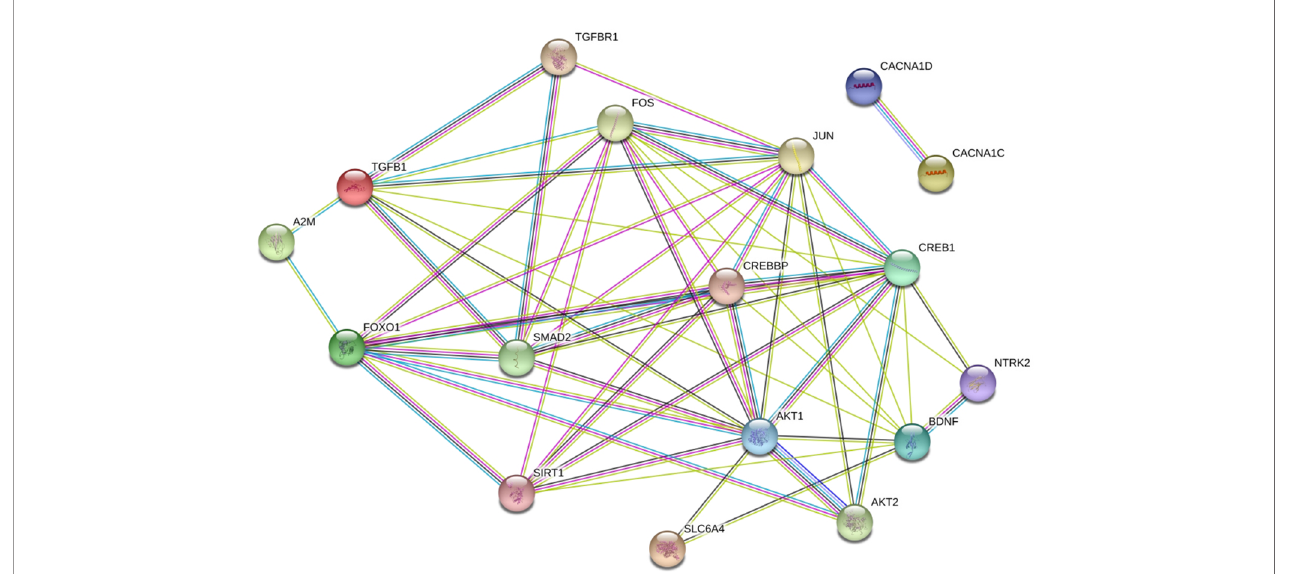
FIGURE 3 | Proteins encoded by FoxO1, A2M, and TGF- b 1 in a densely interconnected protein-protein interaction (PPI) network formed by susceptibility genes of MDD. (33) The amaranthine lines indicate known PPIs that have been experimentally determined, and the light blue lines indicate known PPIs from curated databases. The green lines indicate predicted interactions from gene neighborhood, the dark blue lines indicate predicted interactions through gene co-occurrence and the black lines indicate known PPIs from co-expression. The light green lines indicate predicted PPIs through text